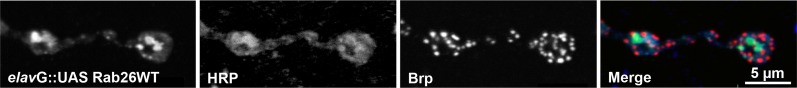
Rab26 does not colocalize with the presynaptic scaffold protein Brp in Drosophila neuromuscular junctions.YFP-tagged Rab26WT localizes to the presynaptic compartment of neuromuscular junctions (NMJs) in Drosophila melanogaster and forms huge structures that overlapped with the presynaptic membrane marker HRP, but not with the active zone marker Bruchpilot (Brp). The YFP tagged wild type Rab26 was expressed using the elav-Gal4 promoter. NMJs of larvae expressing YFP-Rab26WT were stained with anti-GFP (green), anti-HRP (blue) and anti-Brp (red).